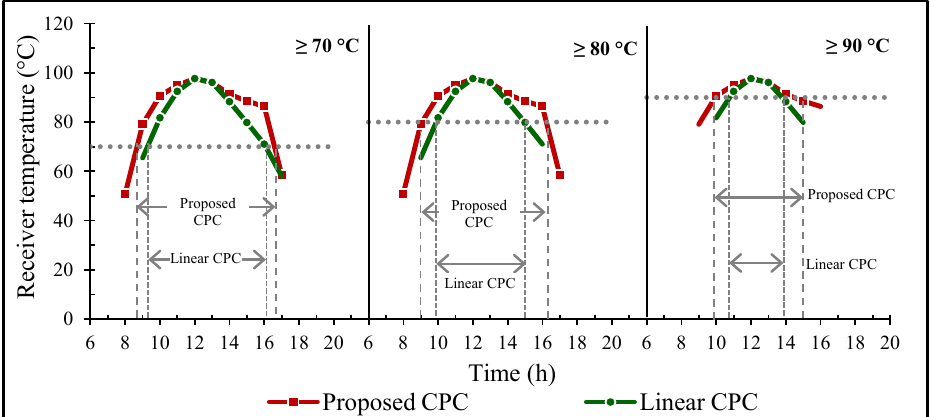
Figure 8. Duration of the selected temperatures per unit length of the proposed angled CPC and linear south-facing CPC (6 May 2005).